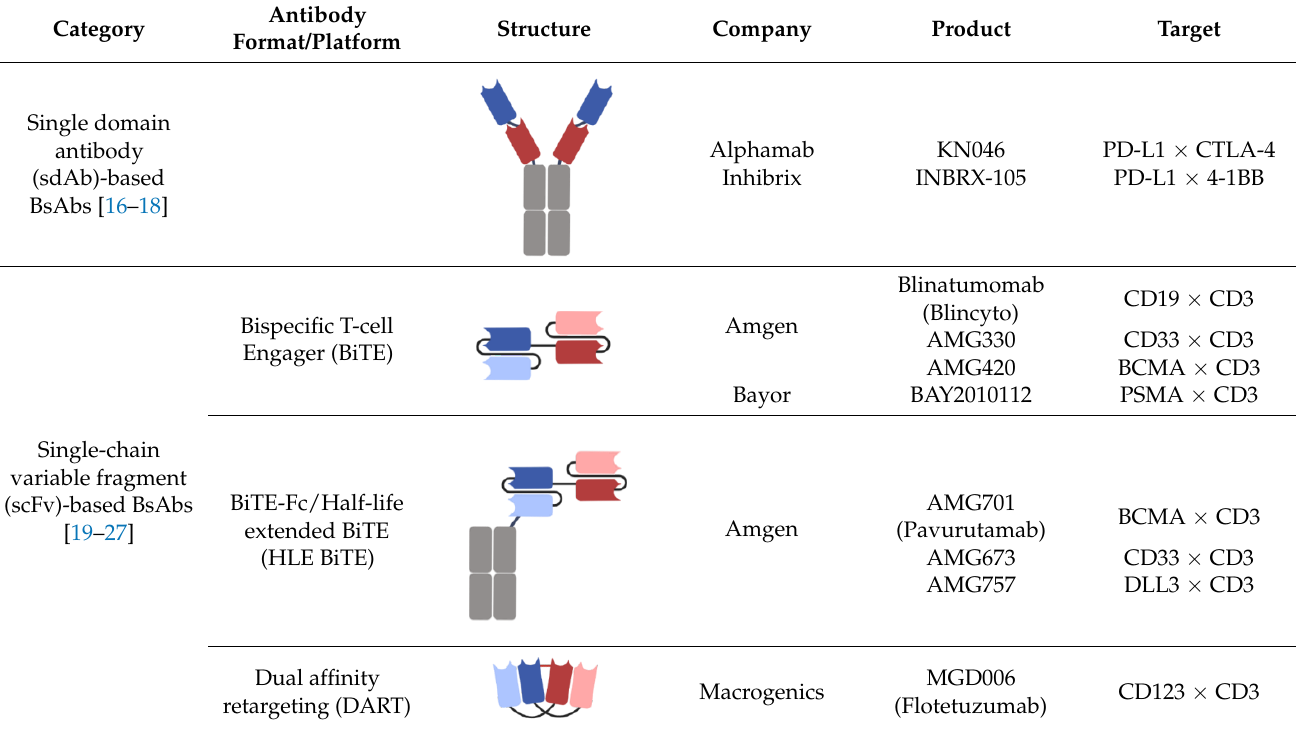
Table 1. Immune modulating bispecific antibody formats in clinical trials for cancer therapy.